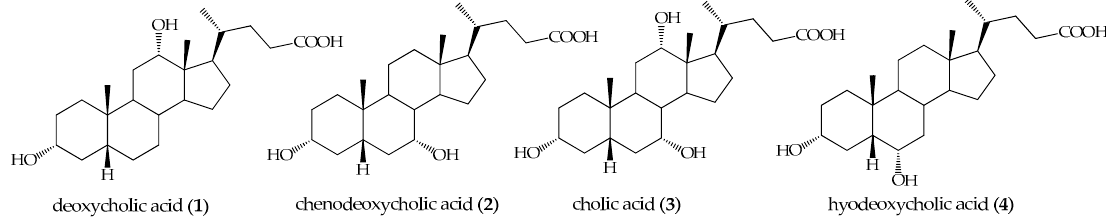
Figure 1. Structure of bile acids used for the synthesis of brassinolide and its analogues.